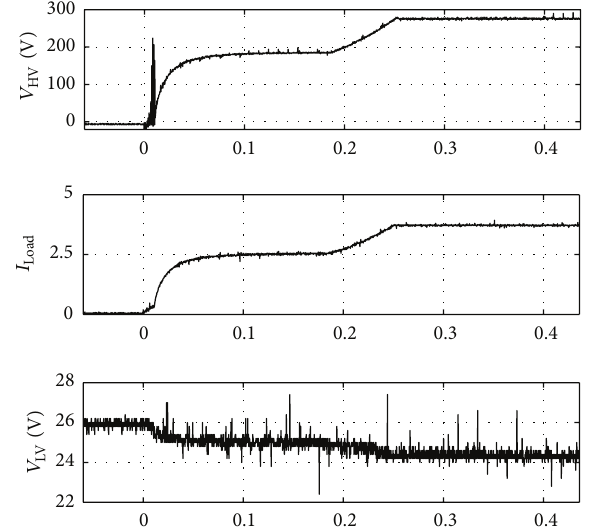
Figure 18: Start-up phase of converter in boost mode, 𝑅